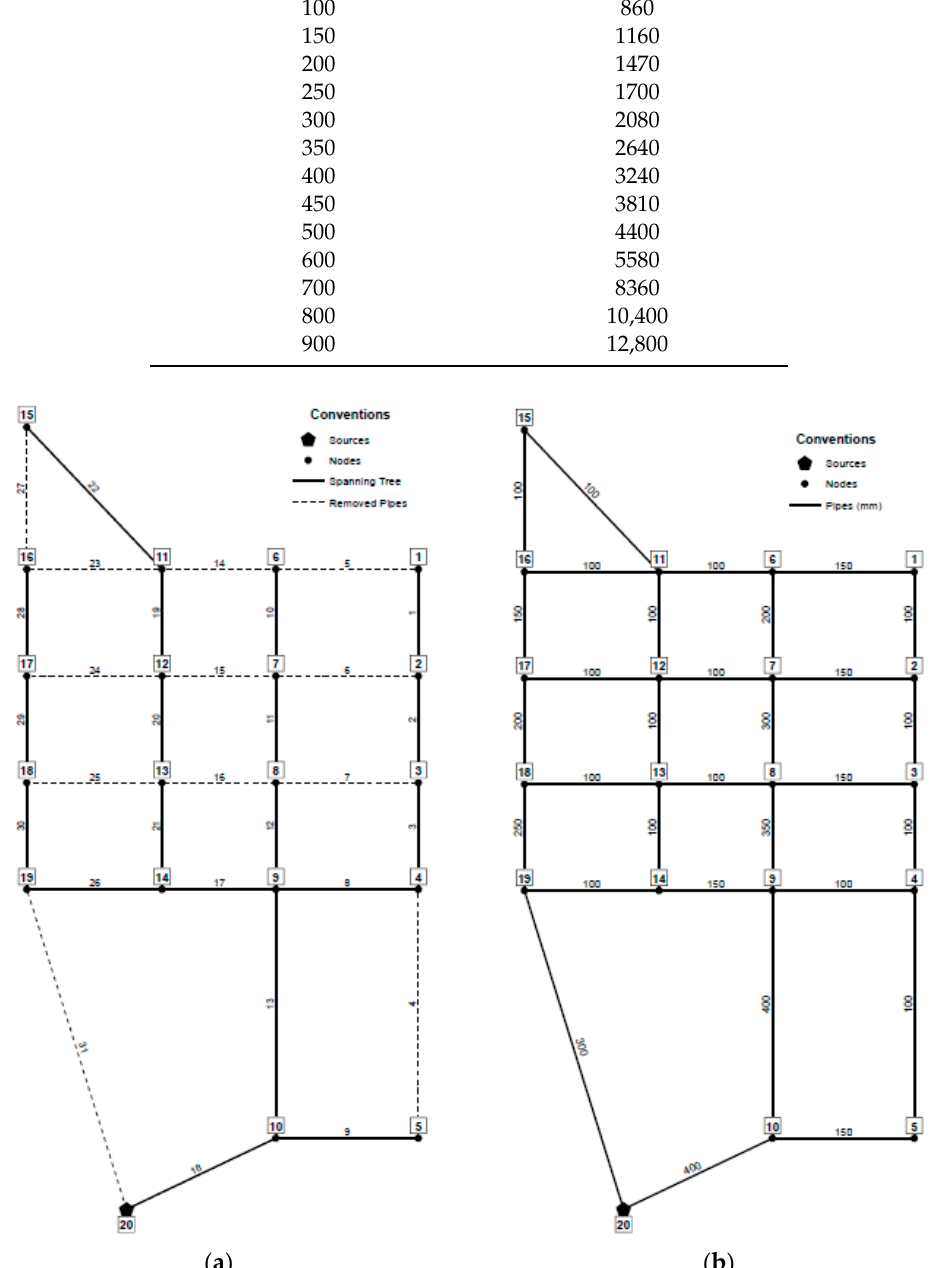
Table 5. Unit costs of Taichung network.